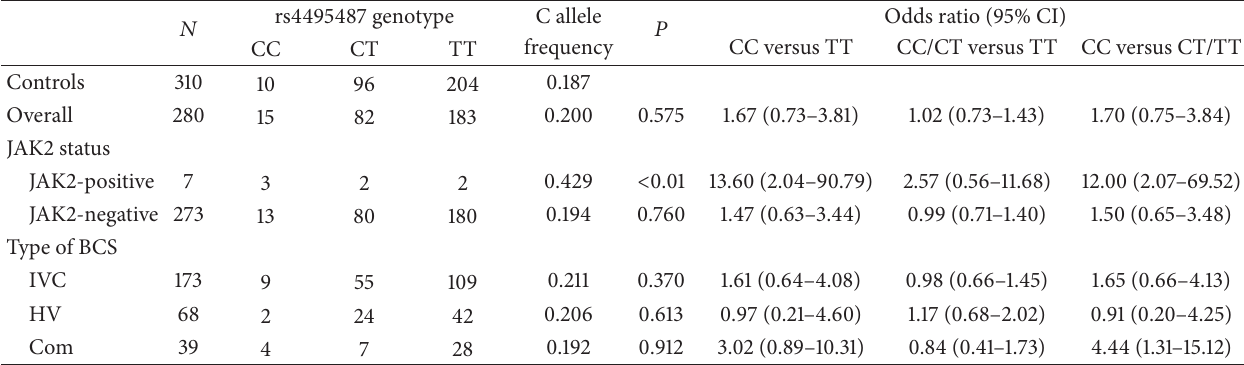
Table 2: Association between JAK2 rs4495487 polymorphism and Budd-Chiari syndrome